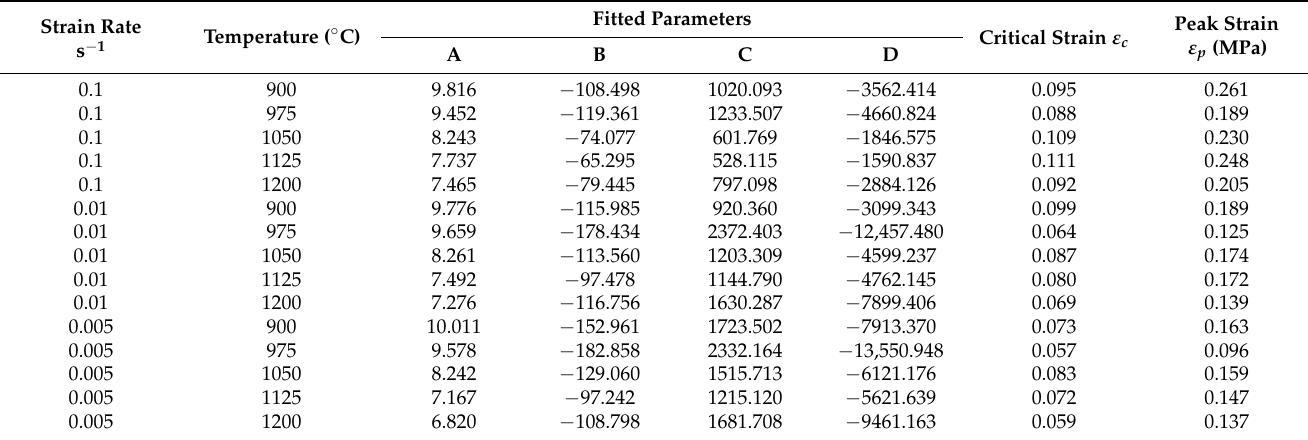
Table 3. Fitted parameters, critical strains and peak strains.